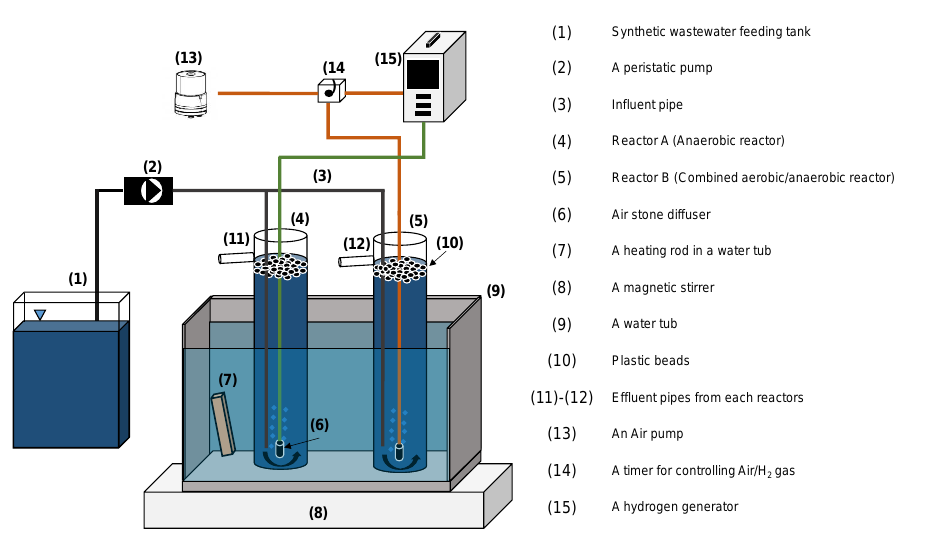
Figure 2. Schematic diagram of the experimental setup. Table 1. Summary of operation conditions.